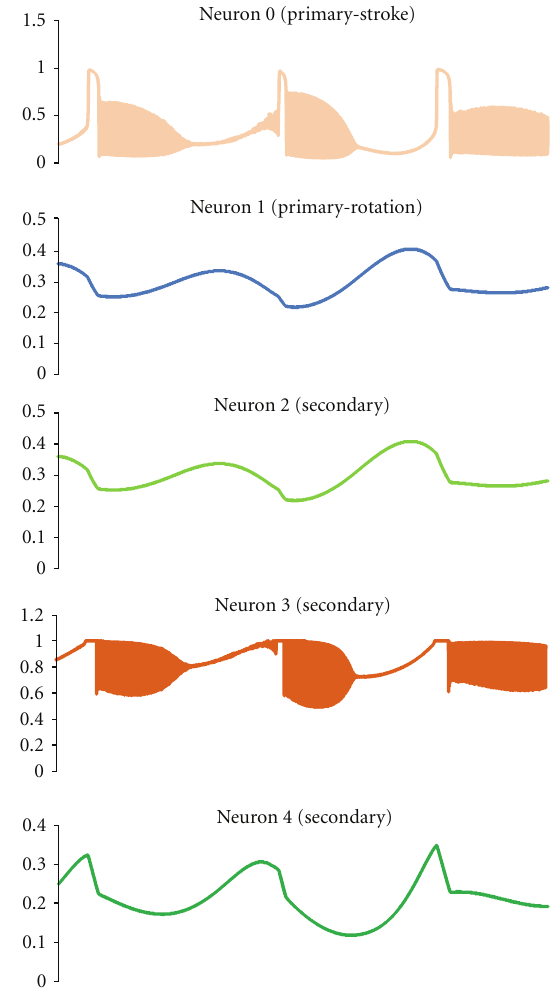
Figure 14: A pictorial representation of the reduced five-neuron architecture of the cruise controller referred in Figure 12. It should be noticed that the primary neurons and secondary neurons retain their position in the network, but neurons 4 and 7 from the original network are positioned in 3rd and 4th locations respectively. The “ ∗ ” indicates that the neurons in this “dynamics-deprived neuron elimination” process-based architecture di ff er from the original neuron in the way that, their bias has been accounted for the eliminated neuron’s saturated output e ff ect on them. So, at least in steady state this reduced network should perform functionally equivalent to the original architecture.